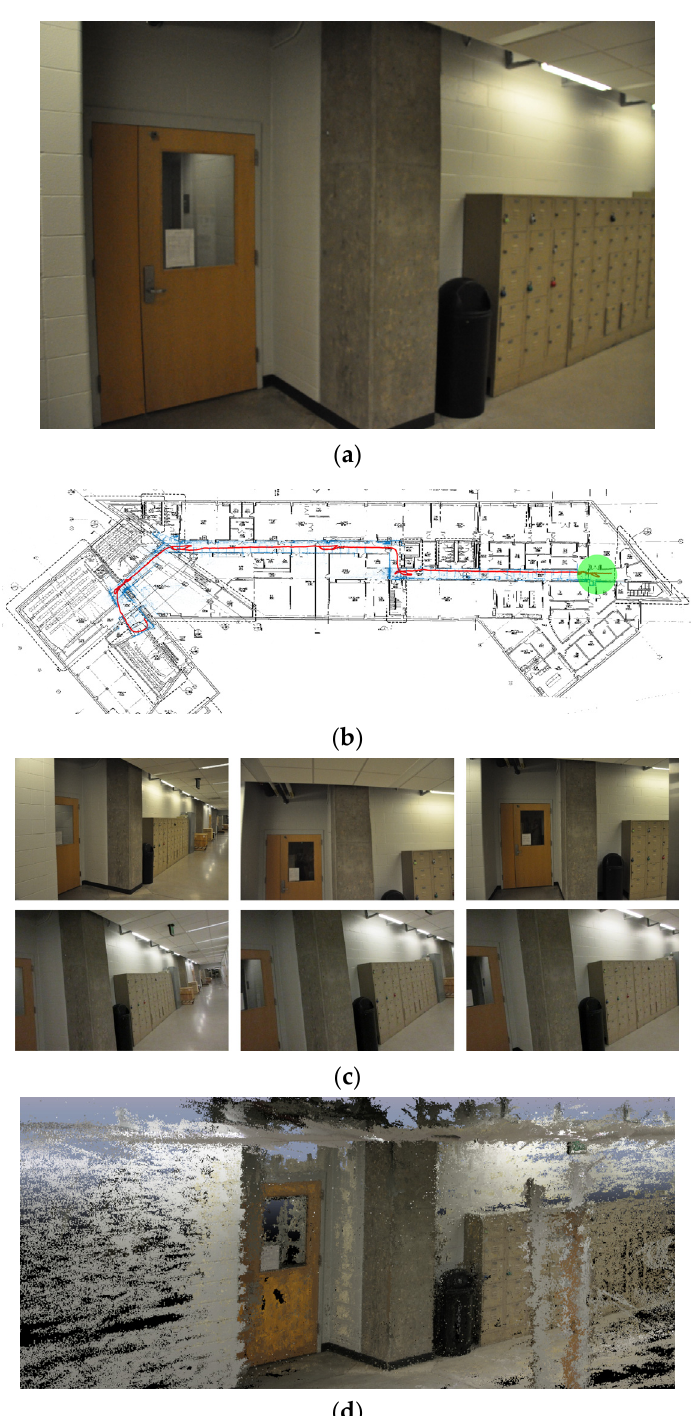
Figure 9. Image localization and local 3D textured model generation: ( a ) selected InspImg, ( b ) its location on the reconstructed drawing, ( c ) InspImgs (first row) and PathImgs (second row) collected at a similar time when the selected InspImg is taken, and ( d ) reconstructed local 3D textured model.